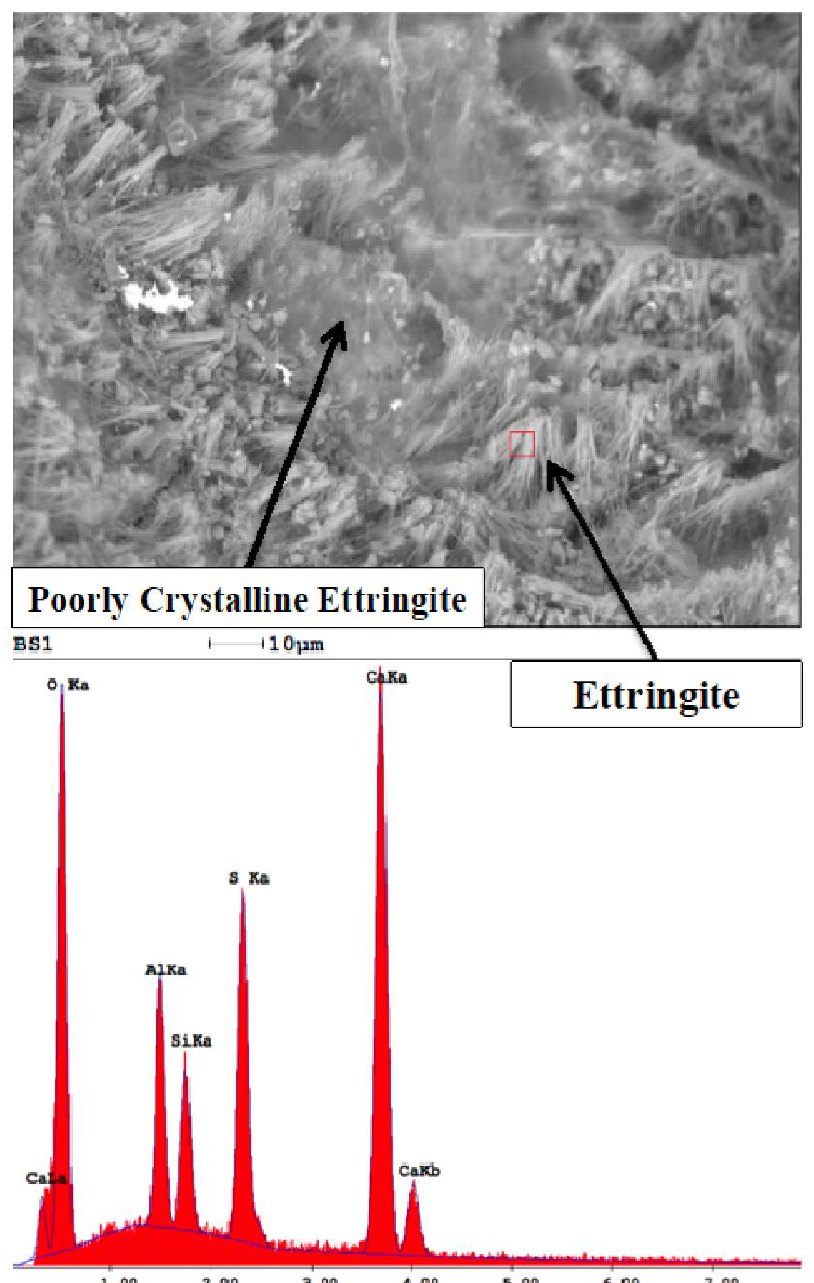
Figure 6. SE image coupled with EDS spectrum showing significant ettringite formation in C1-30HC mixture after 4 months exposure in 5% Na 2 SO 4.